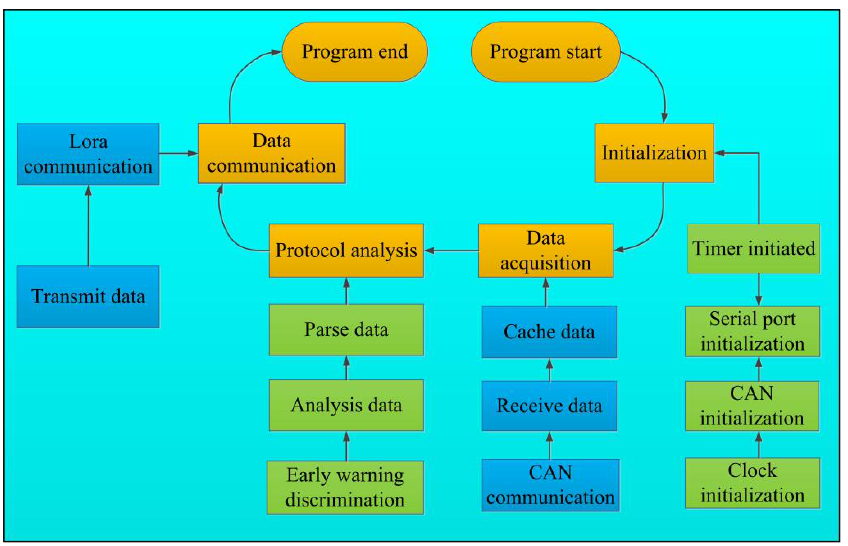
Figure 5. Software design architecture diagram.